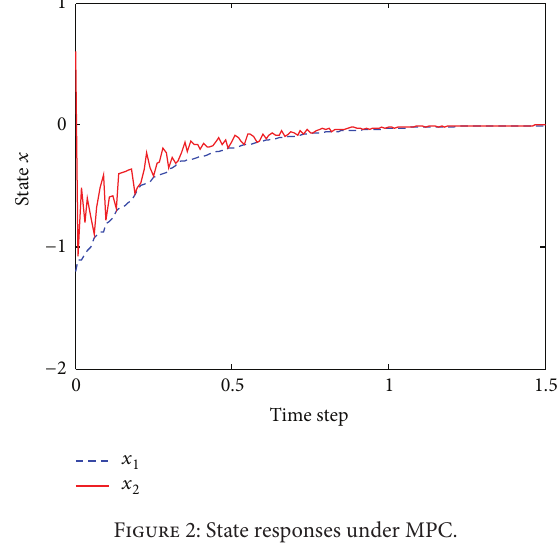
Figure 2: State responses under MPC.